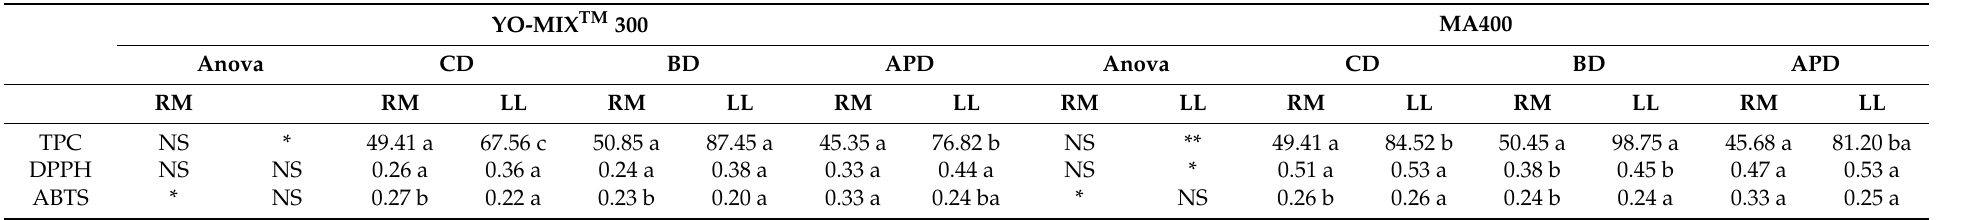
Table 8. Values of total phenols and antioxidant capacity in raw milk (RM) and fermented milk manufactured by late lactation milk and stored for 30 days with milk from Murciana-Granadinas goats fed with differentiated diets, using a thermophilic (YO-MIX TM 300) and mesophilic (MA400) starter cultures. YO-MIX TM 300 MA400 Anova CD BD APD Anova